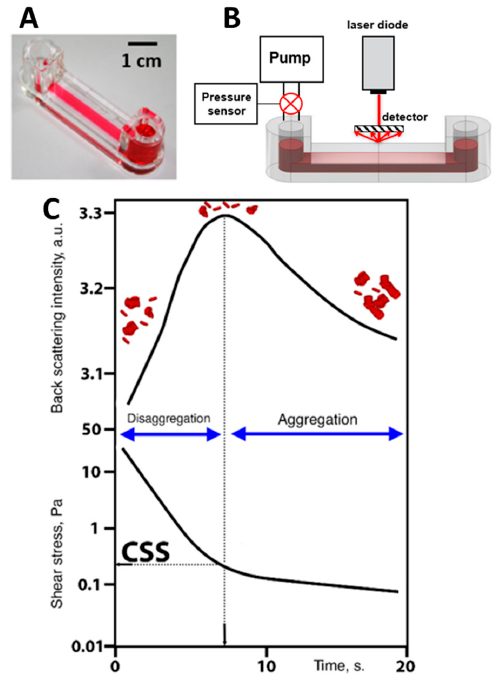
Figure 4. Schematic representation of diffuse light scattering for assessing hydrodynamic strength of RBC aggregates in terms of critical shear stress (CSS). ( A ) Photo of the experimental chip; ( B ) schematic layout of the experimental chip with the microfluid channel with shear-scanning based on measuring back-scattered light intensity; ( C ) graphs of time-dependencies of back-scattered light intensity and shear stress in the microfluidic channel; two graphs are compared to determine CSS: the critical value of shear stress between disaggregation (region of high back scattering due to small sizes of the scattering objects) and aggregation (region of low back-scattered light intensity due to increasing sizes of RBC aggregates).